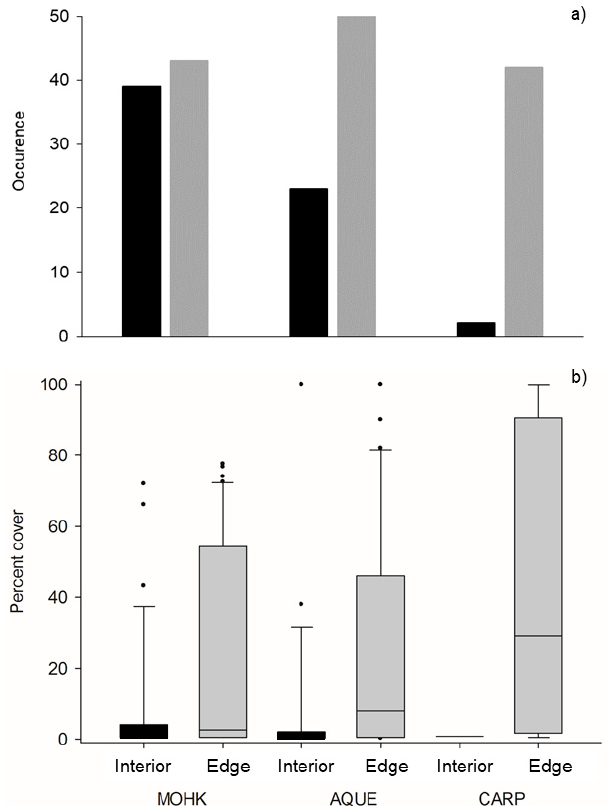
Figure 1. ( a ) Occurrence of Membranipora on kelp blades and ( b ) percent cover of Membranipora on occupied blades. Grey bars indicate edge locations and black bars indicate interior locations at the three sites. Box plots show the median (central line), 25th and 75th percentiles (bottom and top of bars), and 5th and 95th percentiles (whiskers).